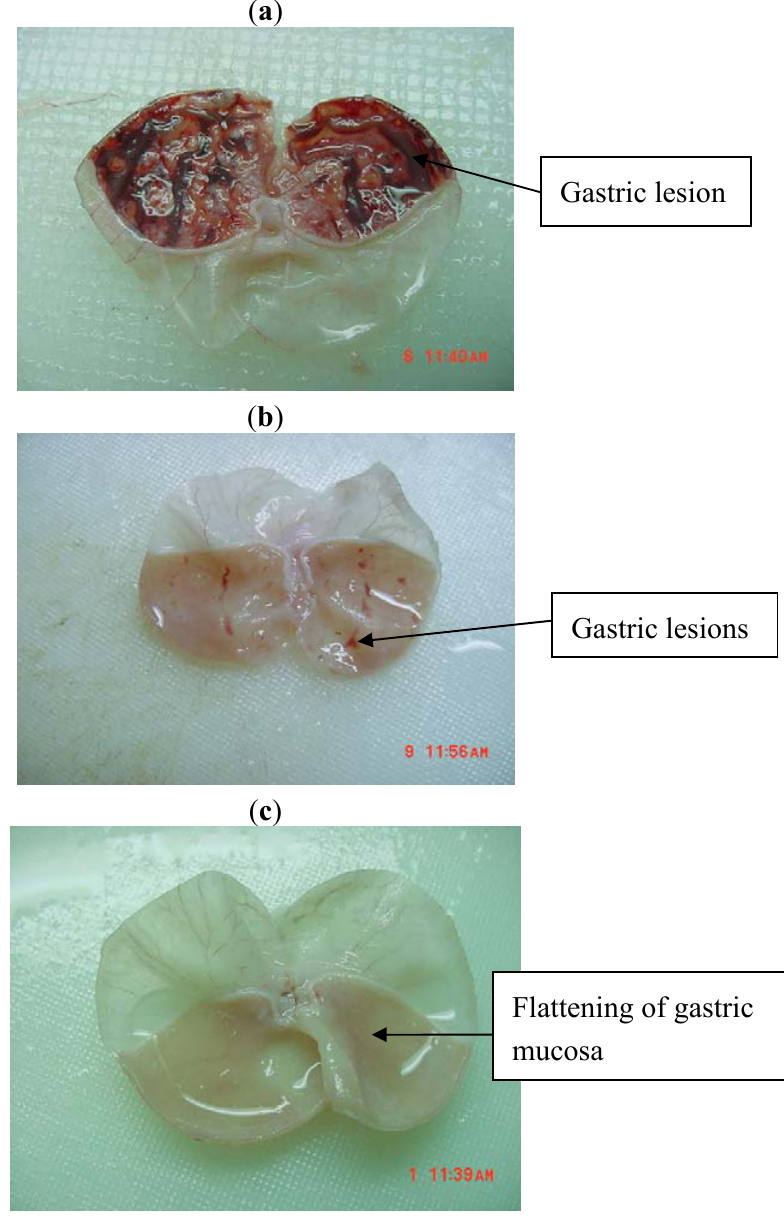
Figure 1. ( a ) Macroscopic appearance of the gastric mucosa in a rat pre-treated with 10 ml/kg of 10% Tween-20 (ulcer control). Severe hemorrhagic mucosal lesions are seen in the gastric mucosa. ( b ) Macroscopic appearance of the gastric mucosa in a rat pre-treated with Cimetidine (50 mg/kg). Injuries to the gastric mucosa are milder compared to the injuries seen in the ulcer control rat. ( c ) Macroscopic appearance of the gastric mucosa in a rat pre-treated with TNS (60 mg/kg). No injuries to the gastric mucosa are seen, and showed flattening of gastric